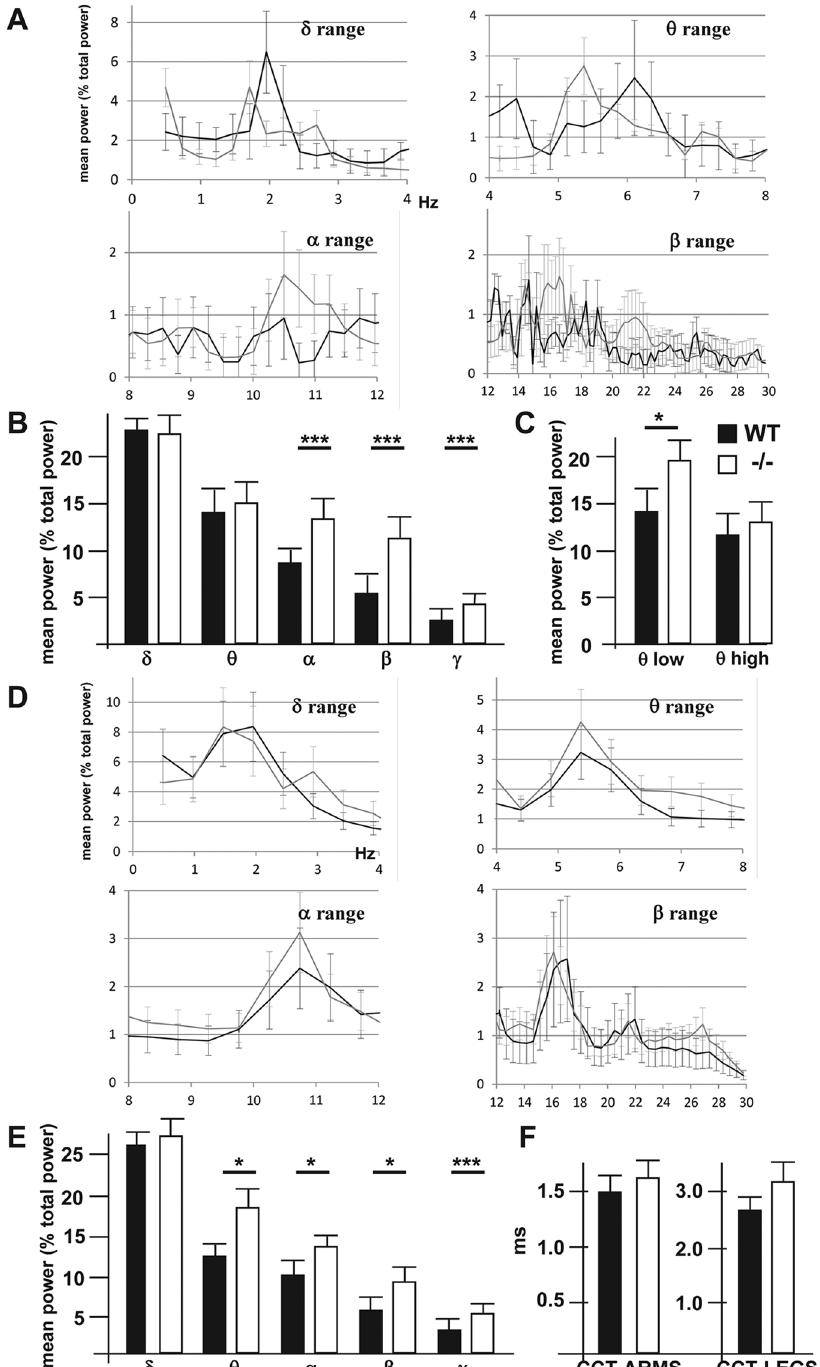
Figure 7. EEG recording from sleeping animals. ( A ) Power spectral profiles of WT (black line) and ArhGAP15 − / − (grey line) animals, at P40. The power of the individual frequency band (1 Hz bins) was normalized by expressing it as % of total power (1–50 Hz for all epochs). ( B ) Averaged normalized power of each EEG band for WT (solid bars) and ArhGAP15 − / − (open bars) animals, at the age P40. Significance is reported on the top. ( C ) Quantitative comparison of the θ activity, subdivided in θ -low and θ -high, for WT (solid bars) and ArhGAP15 − / − (open bars) animals, at the age P40. ( D ) Power spectral profiles of WT (black line) and ArhGAP15 − / − (grey line) animals, at P180. The power of the individual frequency band (1 Hz bins) was normalized by expressing it as % of total power (1–50 Hz for all epochs). ( E ) Same as in ( B ), recorded in WT and ArhGAP15 − / − animals, at P180. ( F ) Central conductance of the brain-to-arm motoneuron path (left) and the brain-to-leg motoneuron path (right) in WT (solid bars) and ArhGAP15 − / − (open bars) animals, at P45. No difference is detected. Data are presented as mean ± SEM. * P ≤ 0.05, *** P ≤ 0.001 (Student’s